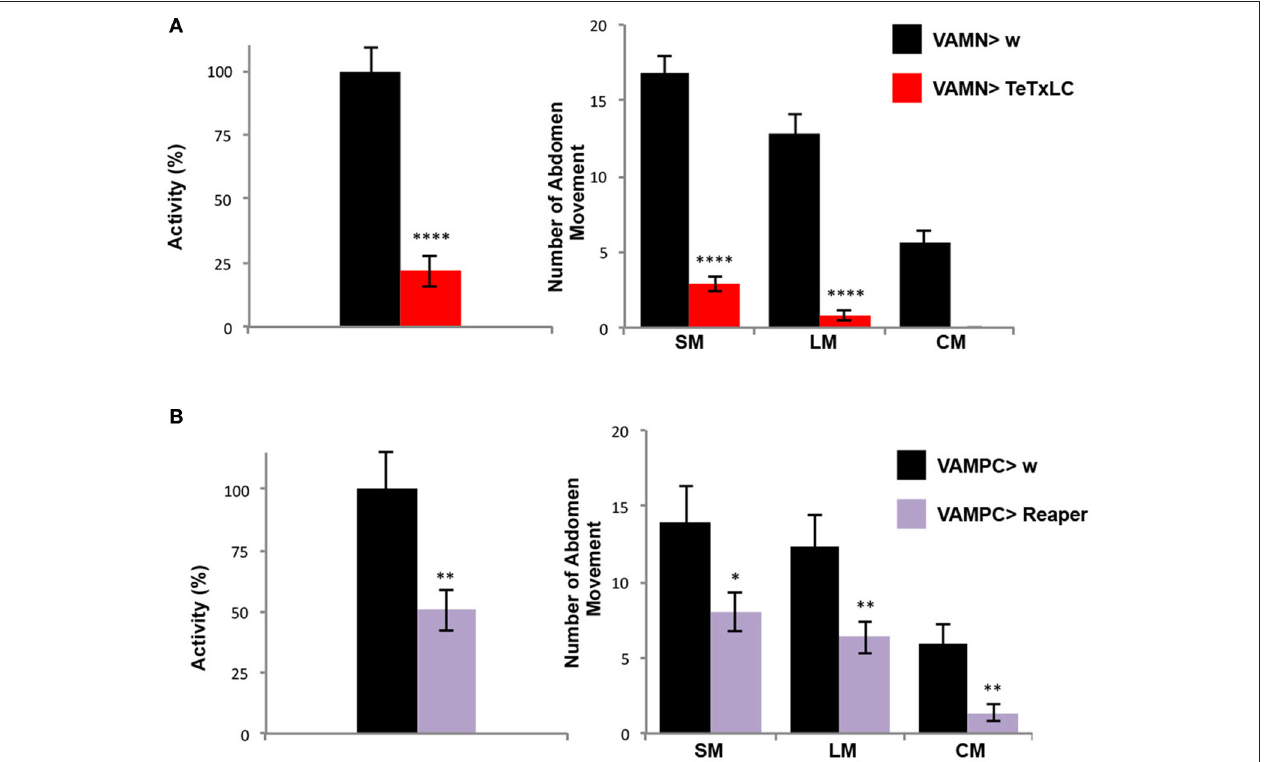
FIGURE 4 | The VAMs are required for the abdomen folding behavior. (A) The specific inactivation of the synaptic transmission at the VAMs level using the expression of the tetanus toxin light chain (TeTxLC) leads to a drop of the abdomen folding activity. A reduction of 78% in activity of the abdomen movements is observed in VAMN Gal4/ + ; UAS TeTxLC/ + flies (in red, n = 31) compared to control flies, VAMN Gal4/ + (in black, n = 29). All types of movements (SM and LM) are affected and the abdomen curving (CM) is abolished when the synaptic transmission to the VAMs is impaired. Pool data are represented as means ± SEM, **** p < 0.0001. (B) Flies expressing reaper in the AMPs of the abdominal muscles (UAS Reaper/ + ; VAMPC Gal4/ + ) show a reduction by half of the folding abdomen activity (in purple, n = 29) compared to the control flies (VAMPC Gal4/ + , in black, n = 15). This result is the consequence of an overall abdomen movement reduction. VAMPC > Reaper flies perform 8 SM, 6LM and 1 CM compared to 14, 12 and 6 respectively in control flies. Pool data are represented as means ± SEM, * p < 0.05, ** p <